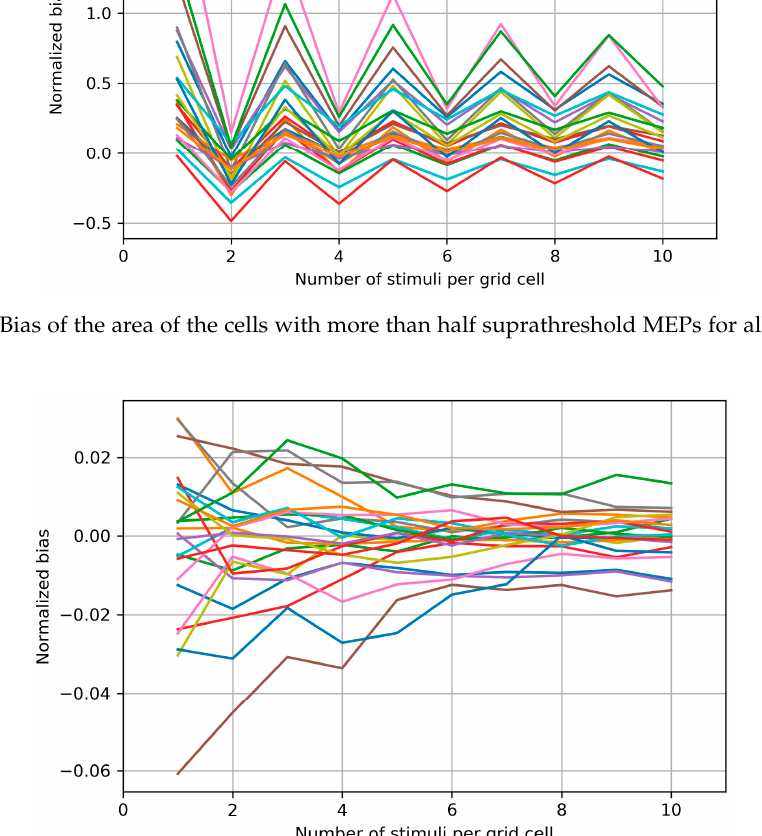
Figure A4. Bias of the area weighted by the mean MEP amplitude for all sessions of all subjects.